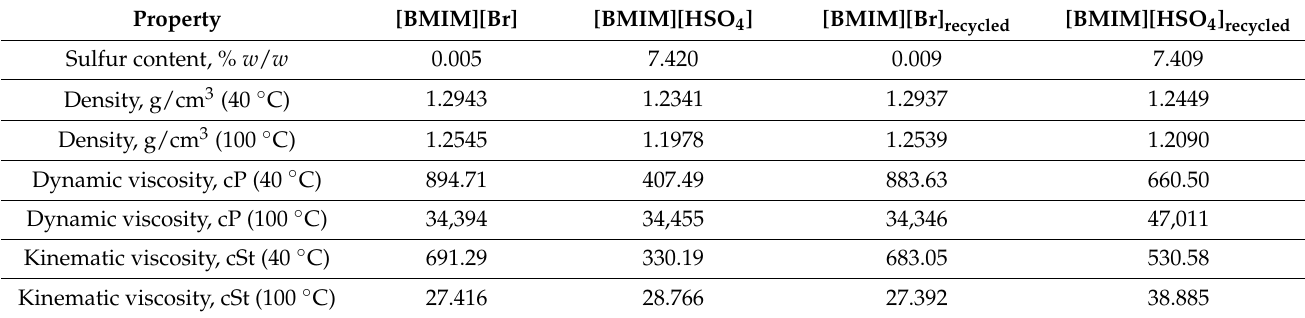
Table 4. Physical properties of the synthesized and recycled ionic liquids